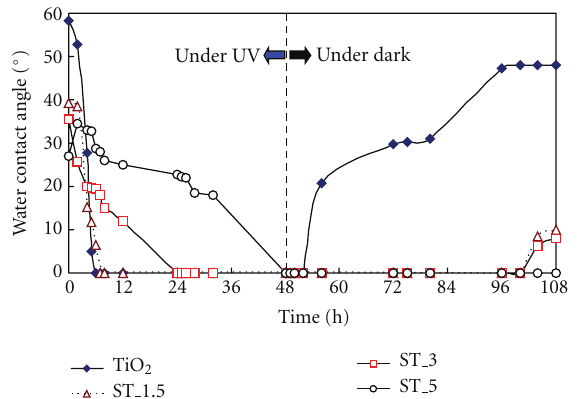
Figure 6: Water contact angle of TiO 2 , ST 1.5, ST 3, and ST 5 thin film coated with oleic acid, first 48 hours irradiated with UV, next 60 hours in dark.